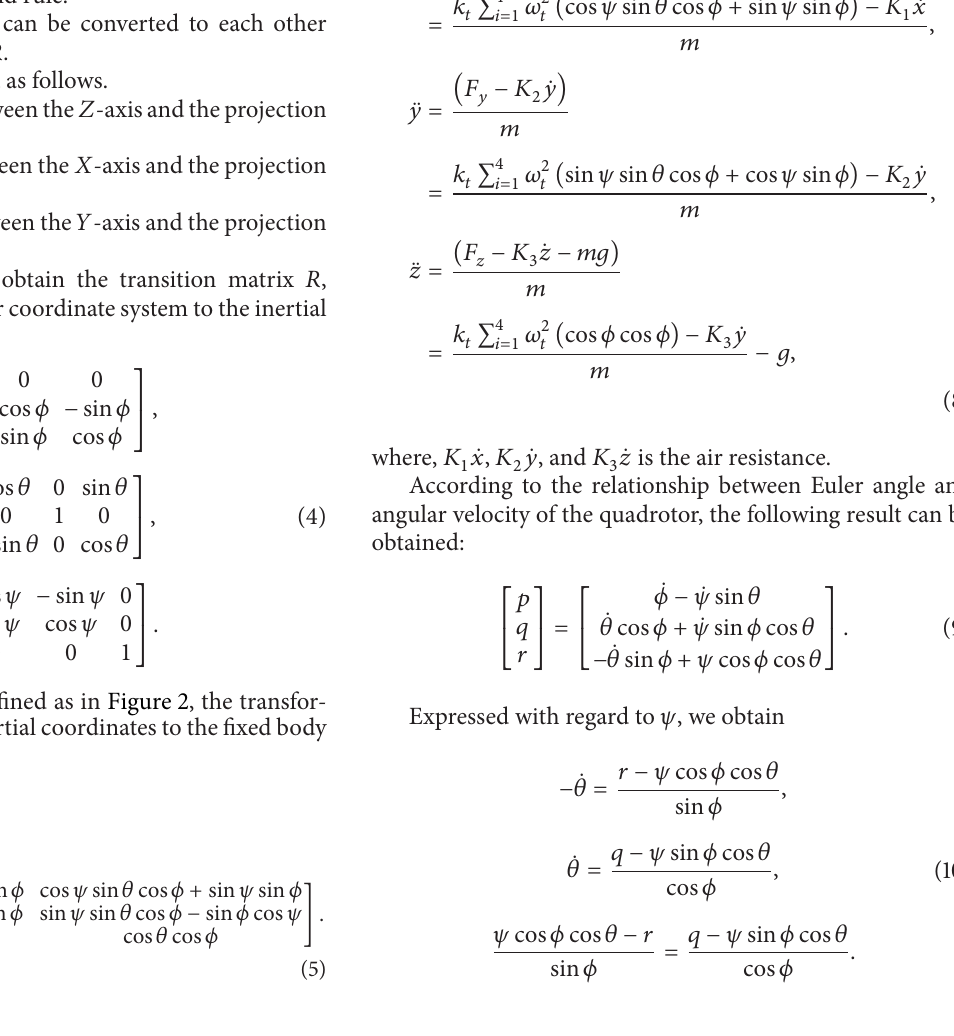
to the 𝑜𝑥𝑧 plane; the positive direction is the direction conforming to the right hand rule.